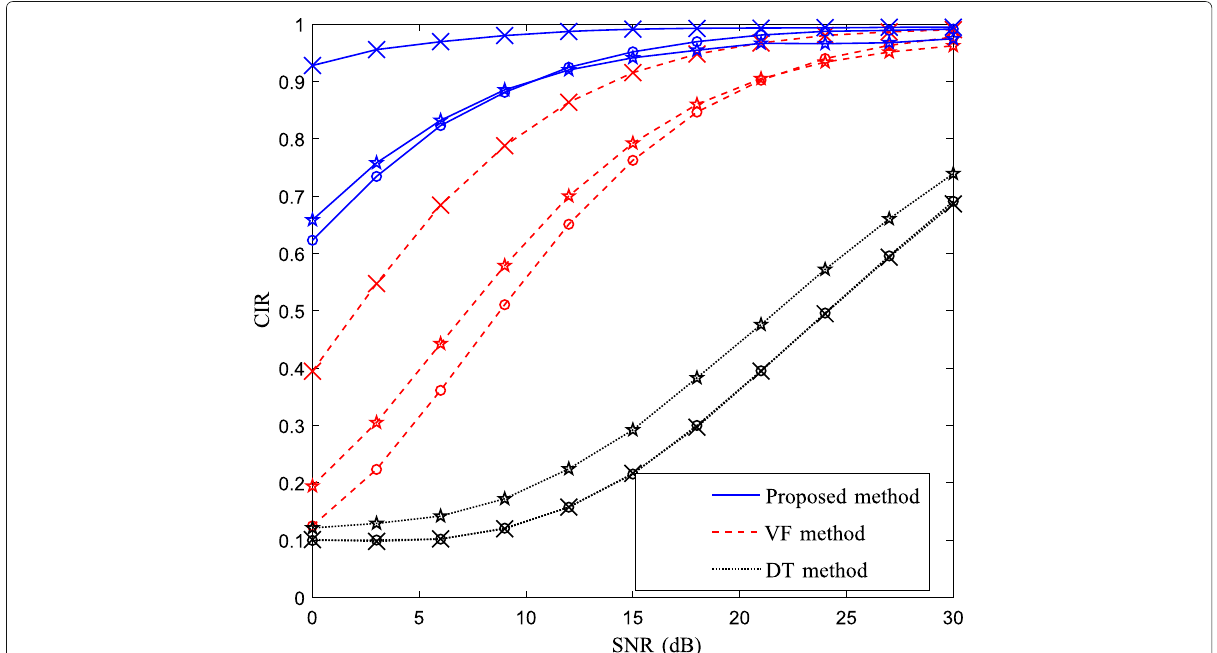
Fig. 9 CIR comparisons between proposed methods and VF- and DT-based methods. The cross marker denotes N = 512 and P FA = 1%, the star marker denotes N = 32 and P FA = 5%, and the circle marker denotes N = 32 and P FA =